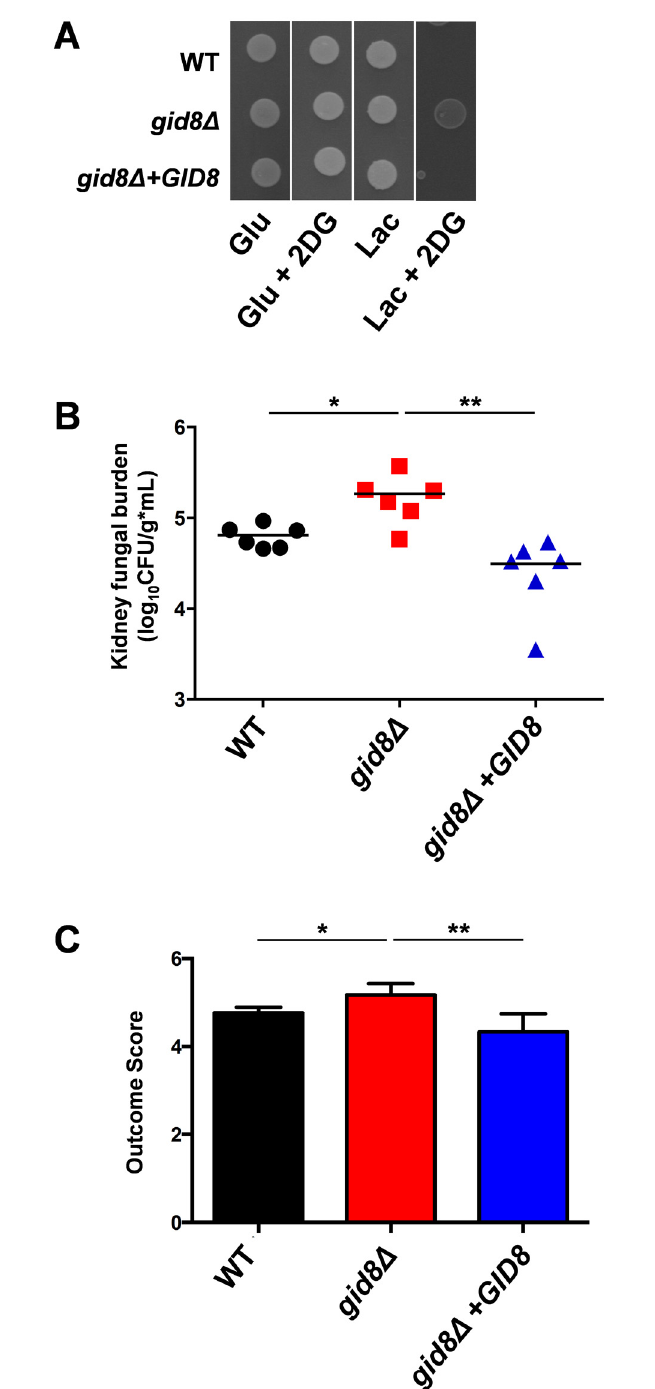
Fig 10. A Crabtree negative S . cerevisiae strain is more virulent in immunocompromised mice. (A) Inactivation of GID8 in S . cerevisiae clinical isolate NCPF8313 renders it 2-deoxyglucose resistant. S . cerevisiae strains were pre-grown in YNB-lactate and spotted on SC medium with glucose (Glu) or lactate (Lac) in the presence or absence of 2-deoxyglucose (2DG): WT, DCY145; gid8 Δ , DCY150; gid8 Δ +GID8, DCY148 (S2 Table in the supplementary information). (B) Immunodeficient DBA/2 mice were injected via lateral tail vein with the same S . cerevisiae strains and renal fungal burdens were measured after 72 h (n = 6 per group). Points represent the CFUs for each animal and the bar denotes the mean. (C) The infection outcome scores were then determined by combining the renal fungal burdens with the percentage